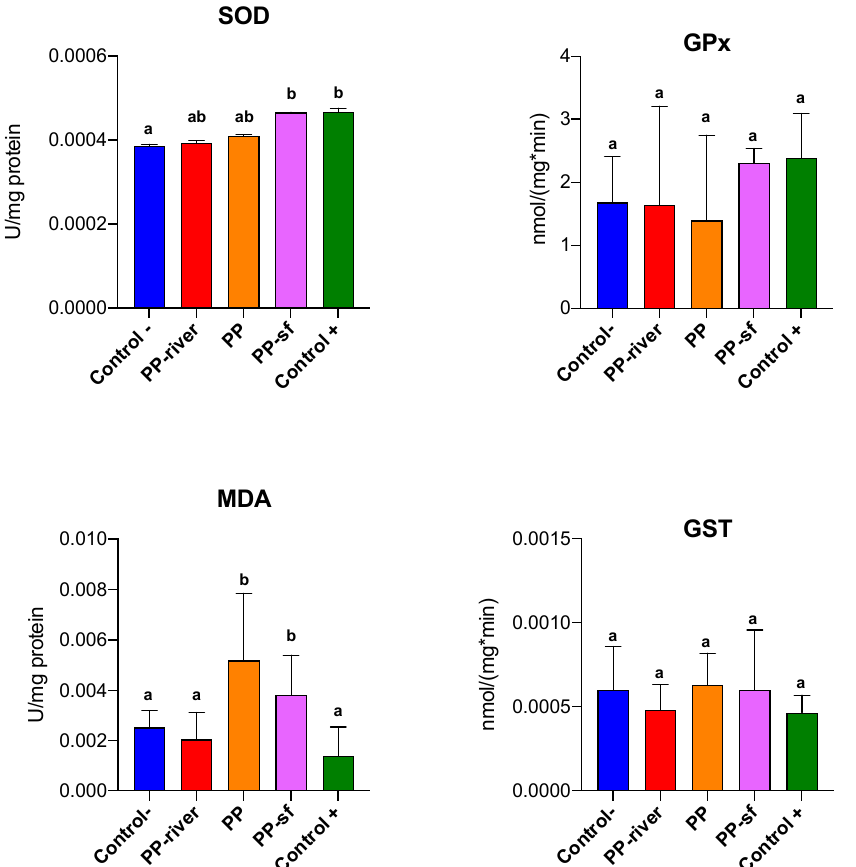
Figure 6. Oxidative stress biomarkers in Hydropsyche pellucidula larvae exposed to treatments for 10 days. SOD (superoxide dismutase; U/mg protein); GPx (glutathione peroxidase; nmol/min mg protein); MDA (malondialdehyde; U/mg protein), GST (glutathione S-transferase; nmol/min mg protein). Mean ± standard deviation, n = 6. Control − denotes negative control; PP polypropylene unconditioned; PP-sf denotes polypropylene preconditioned in Triton X-100 solution; PP-river polypropylene pre-conditioned in riverine water; Control+ positive control. Lowercase letters (a, b) denote differences revealed by Conover–Iman posthoc test.